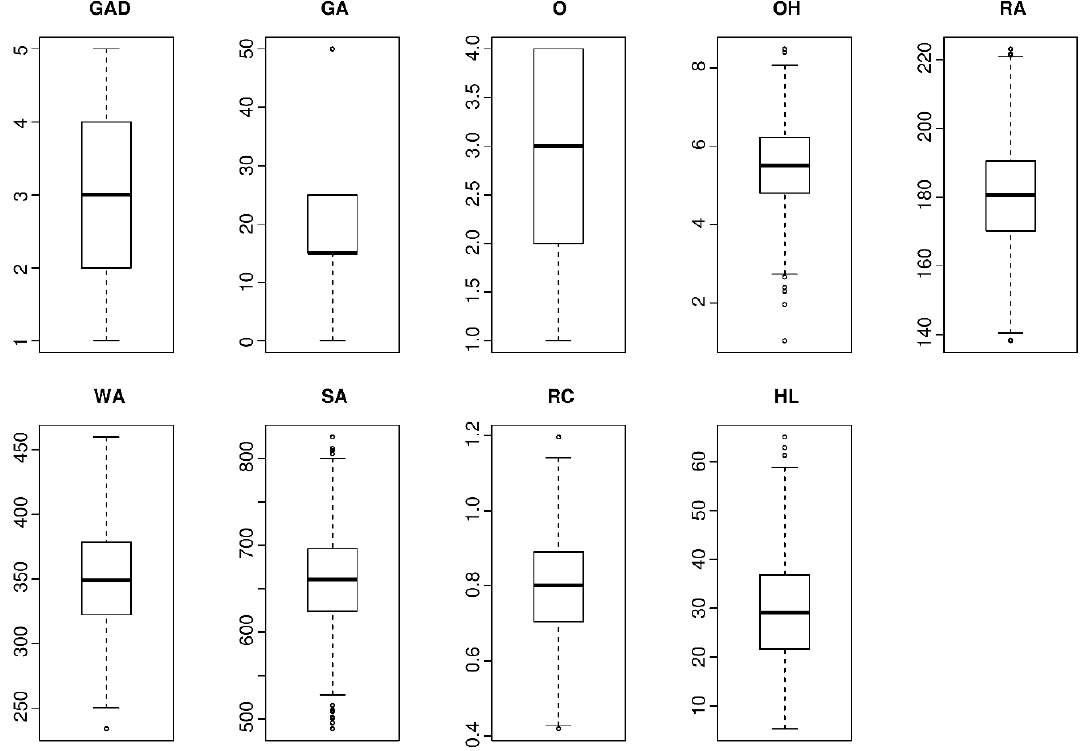
Figure 2. Box and whisker plots of the dataset used for estimating the heating load (HL) in this